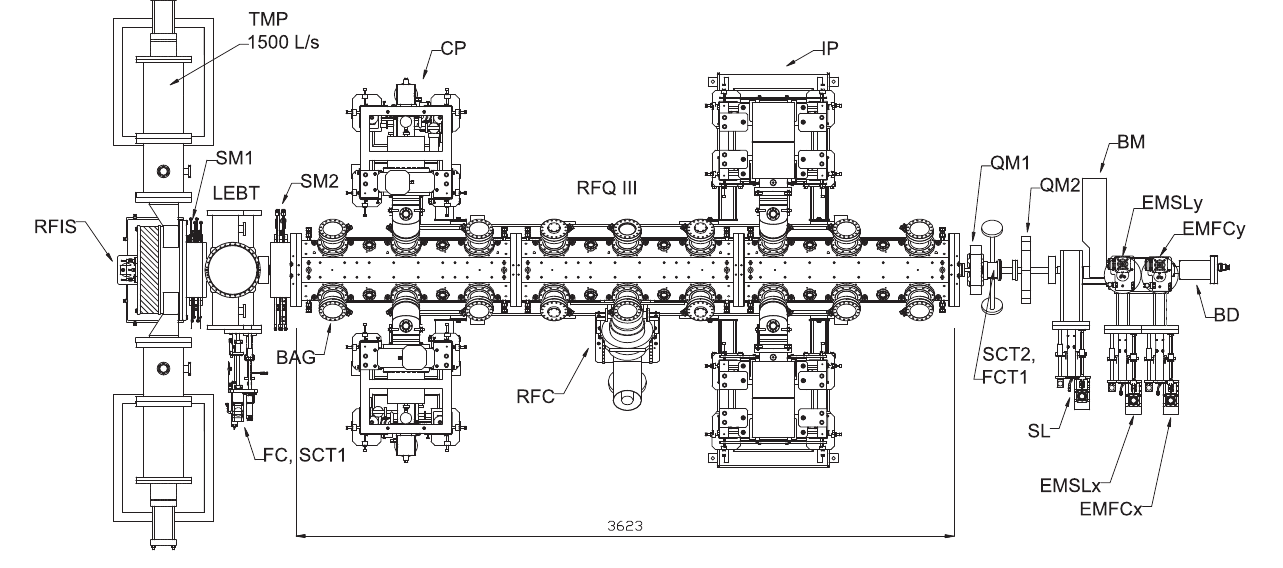
FIG. 1. Schematic of the RFQ test stand (top